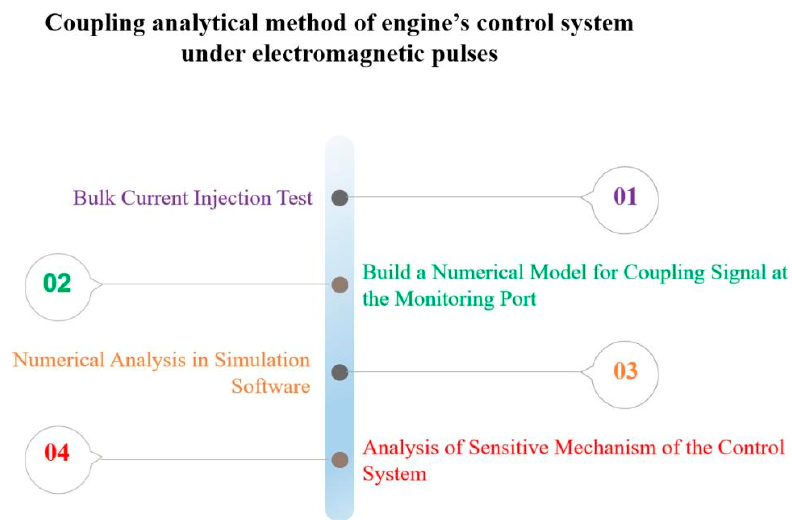
Figure 2. Coupling analytical method under electromagnetic pulses.